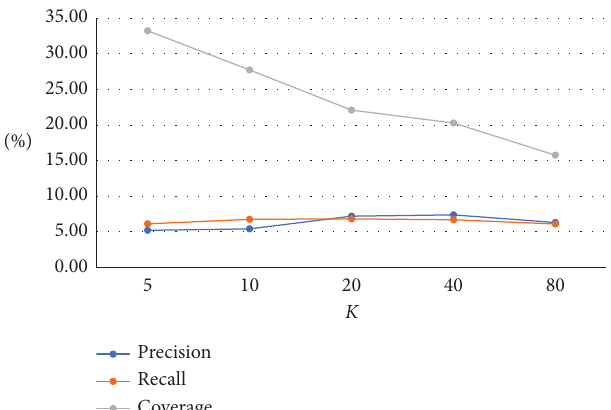
Figure 6: Based on the Pearson correlation coefficient, user similarity calculation is performed under multiple K values.